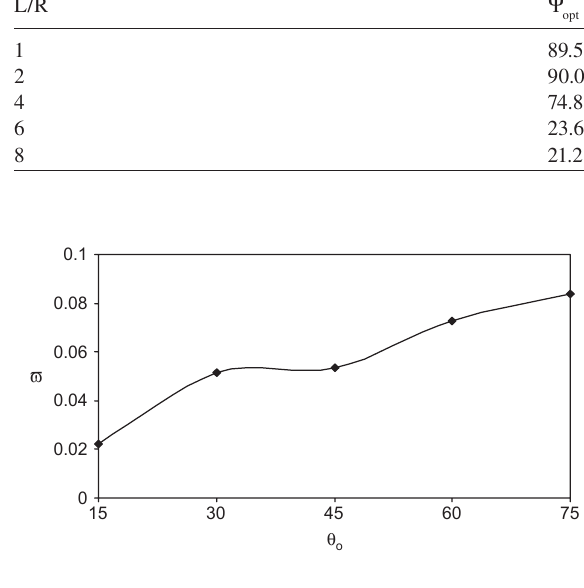
Effect of subtended angle on the optimum fundamental frequencies.